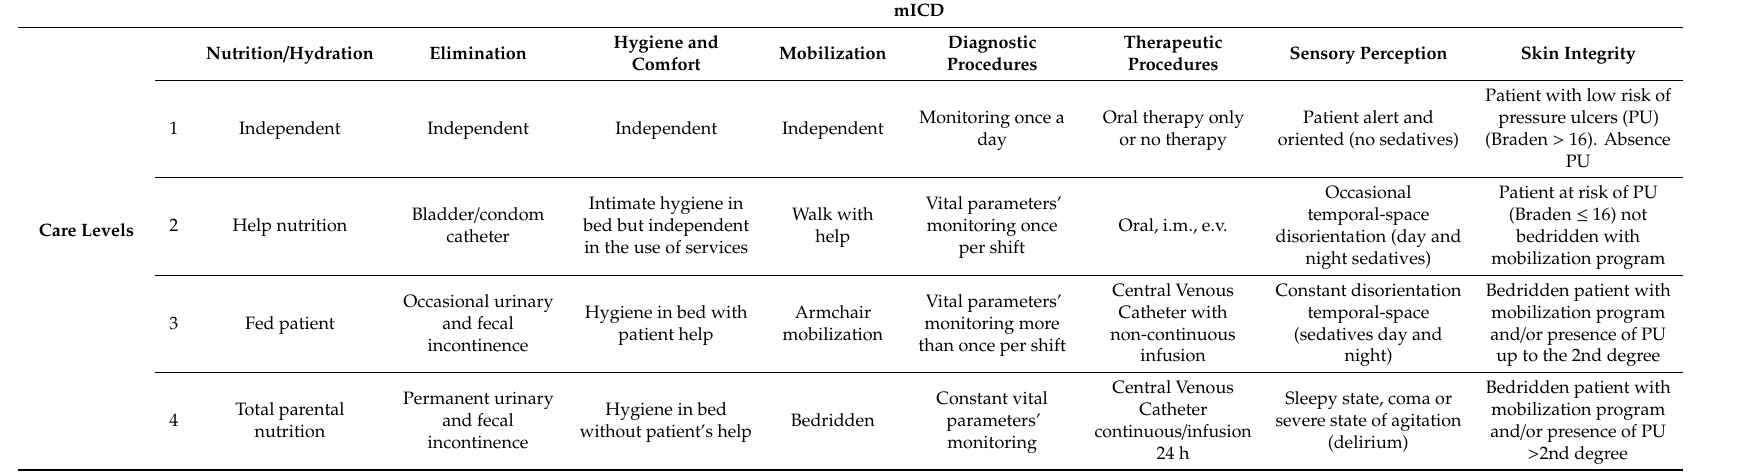
Table 1. Modified index of caring complexity with eight care dimensions. Source: Piu